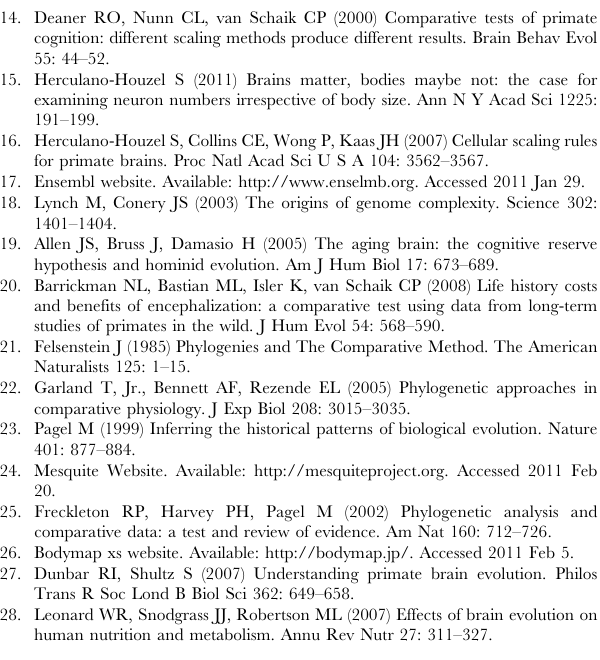
Figure S3 Performance of minimum adequate model (MAM) using mean amino acid frequencies per species as predictors and a random permutation of Ei values as the predicted variable. X axis corresponds to the model-based prediction of the permuted Ei value. Note the lack of significance of the resulting adjusted R 2 coefficient relative to the performance distribution of MAMs obtained for 1000 control permutations of Ei values (Figure 2C of the main manuscript). Table S1 Data and sources for variables used through- out the study. Table S2 Correlation coefficient (R) values and associ- ated probabilities (P) obtained after linear correlations comparing mean genomic AA frequencies and encepha- lization